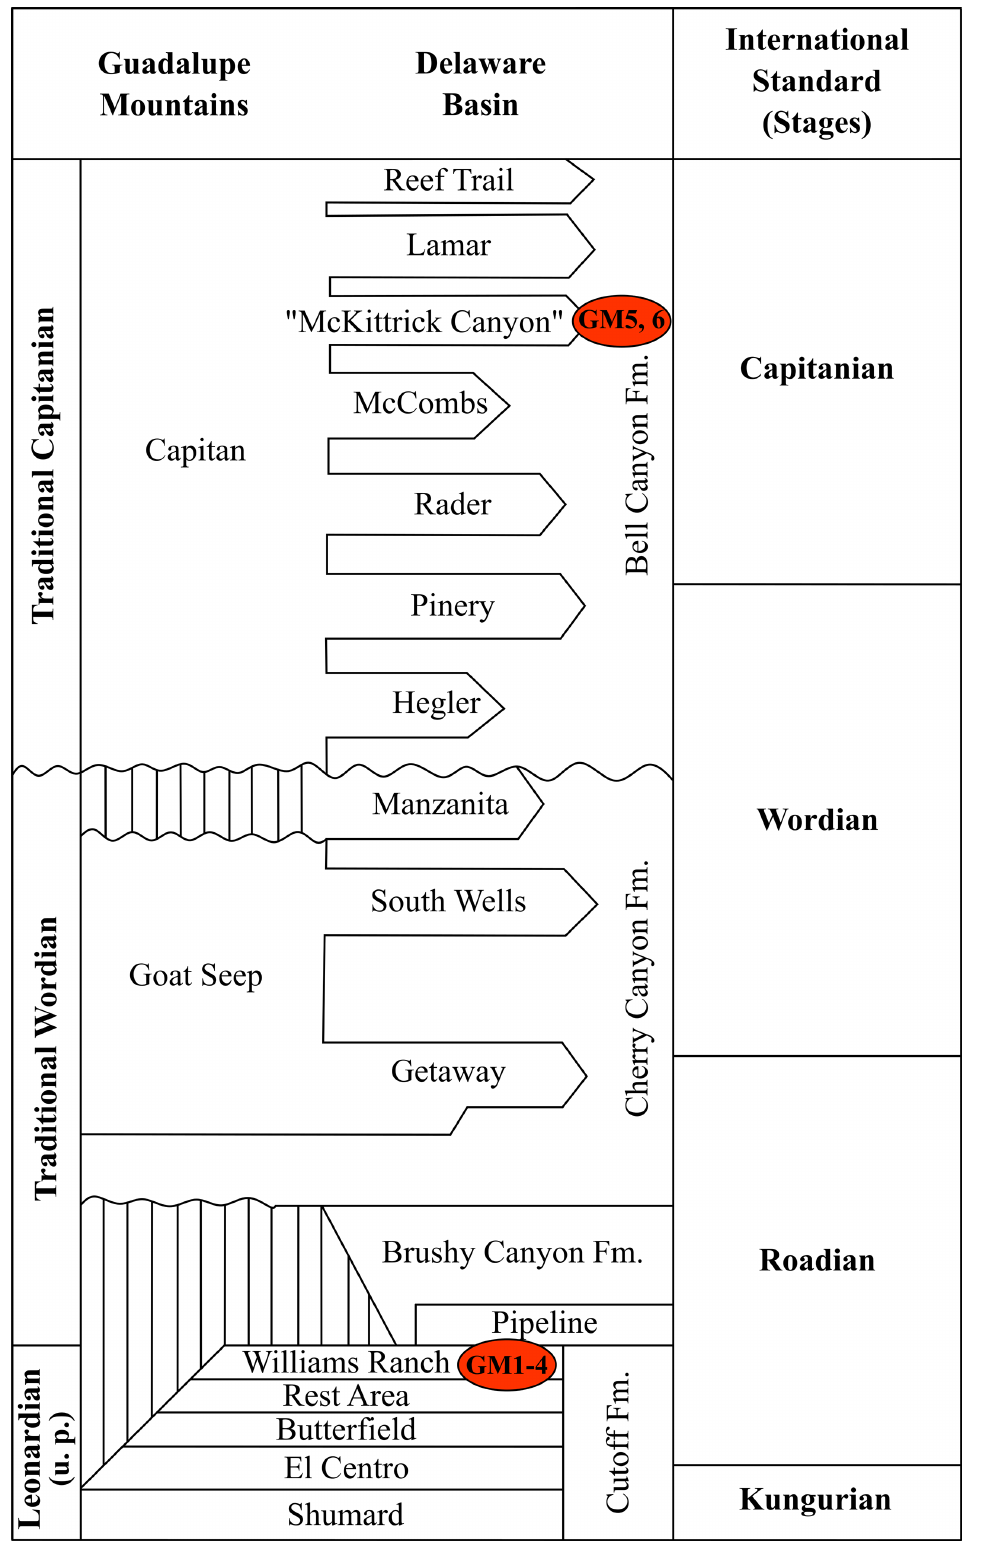
Fig. 2. Stratigraphical units of the Guadalupian in the Delaware Basin area (modified from Wardlaw 2004) and position of the studied Quarry section (samples GM1-GM4) and MKCS1 section (samples GM5, GM6). Abbreviations: u.p. = upper part; Fm. =